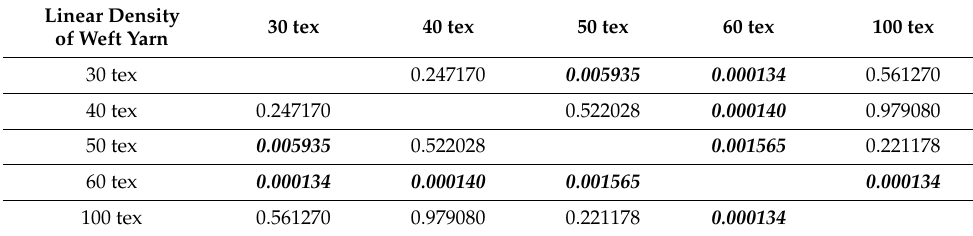
Table 8. The results of the Tukey’s test for the BAR.